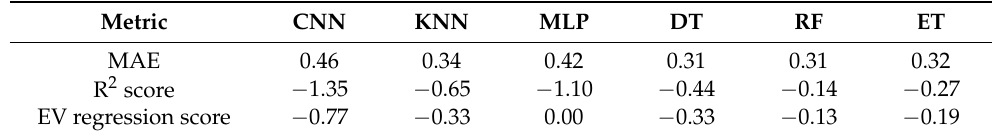
Table 9. Evaluation metrics for validation set of the hologram dataset.